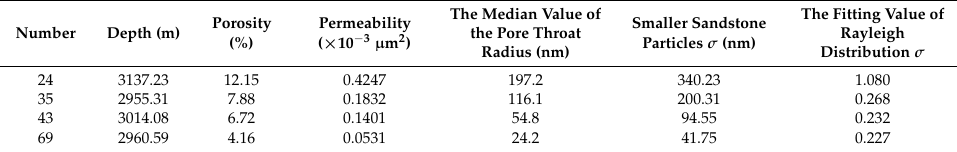
Table 1. The basic parameters of each tight sandstone core.